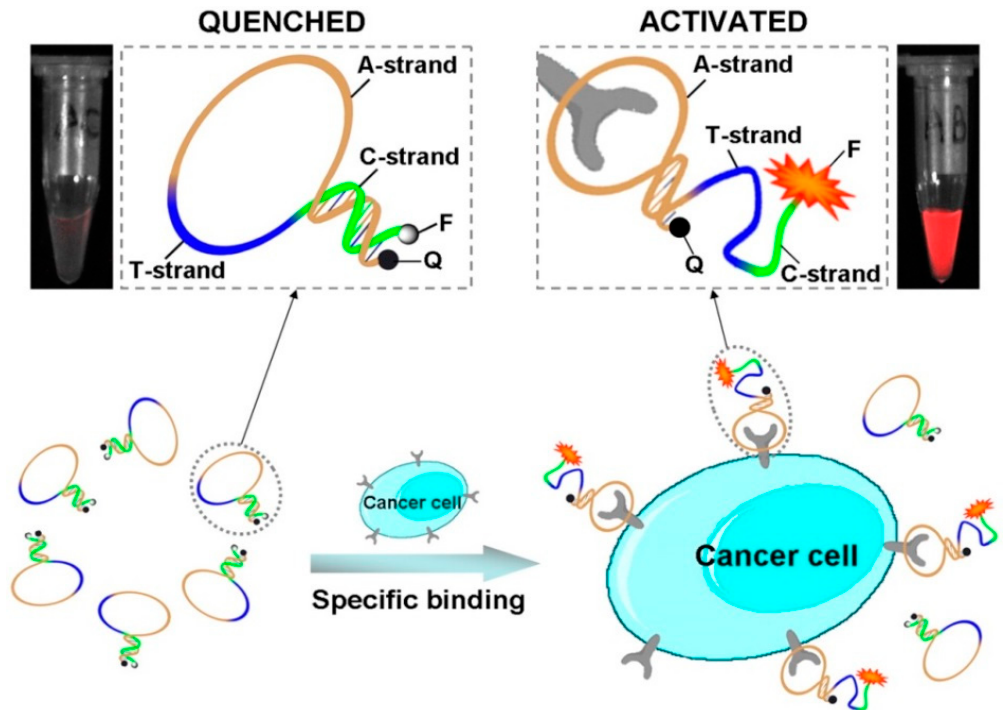
Figure 20. Schematic representation of activatable aptamer probe (AAP)-based strategy for in vitro and in vivo cancer imaging exploiting a cell membrane protein-triggered conformation change. Figure reproduced with permission from reference [231]. Copyright 2011 PubMed Central (PMC).